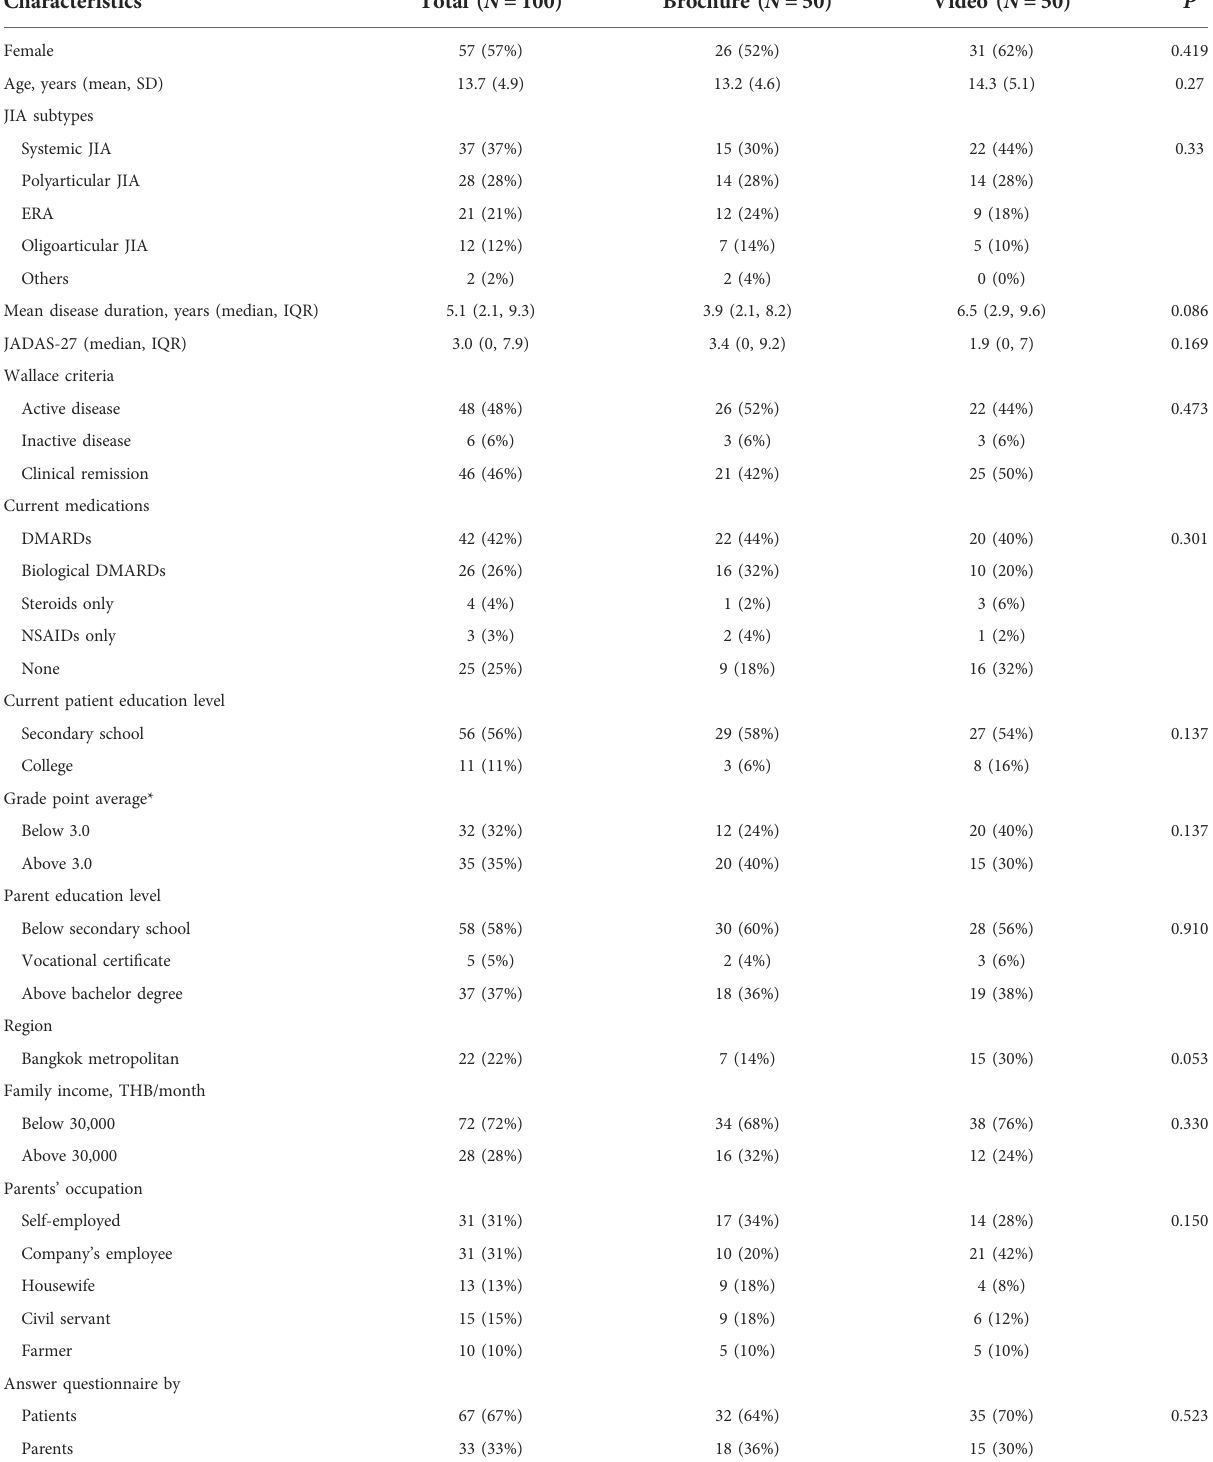
TABLE 1 Baseline and clinical characteristics of 100 participants in the brochure and video